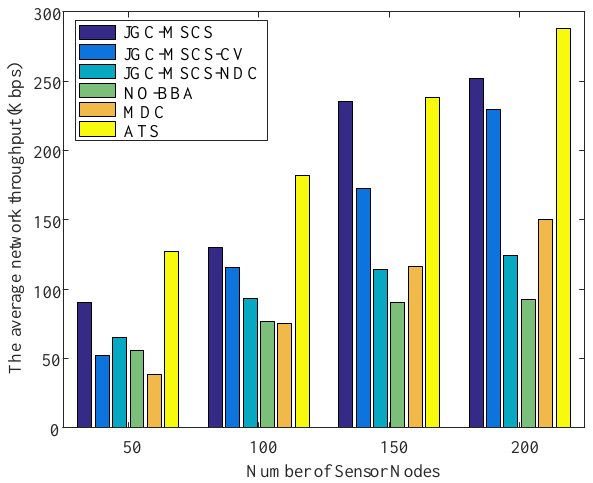
Figure 9. Comparison of the average network throughput of the proposed method with NO-BBA, MDC methods, JGC-MSCS-CV and JGC-MSCS-NDC with different network node densities.